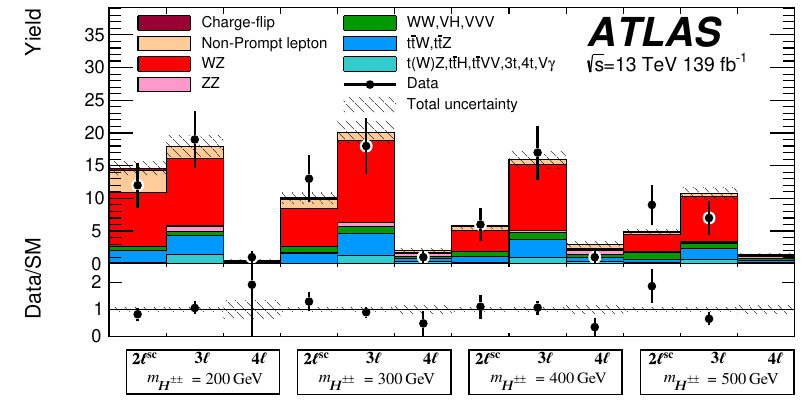
Figure 7 . Data event yields compared with the expected contributions from relevant back- ground sources, for the combination of the individual channels of the 2 ‘ sc , 3 ‘ and 4 ‘ SRs. The = 220 GeV , 350 GeV and 450 GeV signal hypotheses use the signal regions defined for the m H ±± = 200 GeV , 300 GeV and 400 GeV signal. The m m H ±± signal hypotheses use the signal regions defined for the m tainties in the expected event yields are shown as the hatched bands.